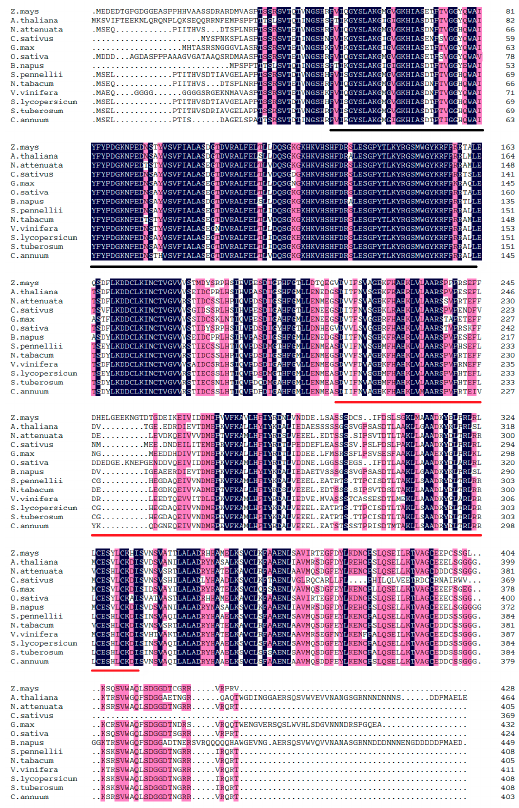
Figure 1. Multiple sequence alignment of the ZmBPM4 / mab17 ( Zea mays , ACG37150.1), AtBPM4 ( Arabidopsis thaliana , NP_566212.2), NaBPM4 ( Nicotiana attenuate , XP_019251977.1), CsBPM4 ( Cucumis sativus , XP_011653454.1), GmBPM4 ( Glycine max , XP_006604260.1), OsBPM4 ( Oryza sativa , XP_015646533.1), BnBPM4 ( Brassica napus , XP_013729393.1), SpBPM4 ( Solanum pennellii , XP_015056619.1), NtBPM4 ( Nicotiana tabacum , XP_016504598.1), VvBPM4 ( Vitis vinifera , XP_002277148.1), SlBPM4 ( Solanum lycopersicum , XP_004251235.1), StBPM4 ( Solanum tuberosum , XP_006340346.1) and CaBPM4 (ACM67640.1) proteins. Dark-blue and gray-pink shading reflects 100% and 75% percent amino acid residues conservation, respectively. Gaps (-) were introduced to maximize alignment. A red solid line shows the Broad-complex Tramtrack and Bric-a-brac (BTB) domain, and a dark solid line shows the meprin and TRAF homology (MATH)